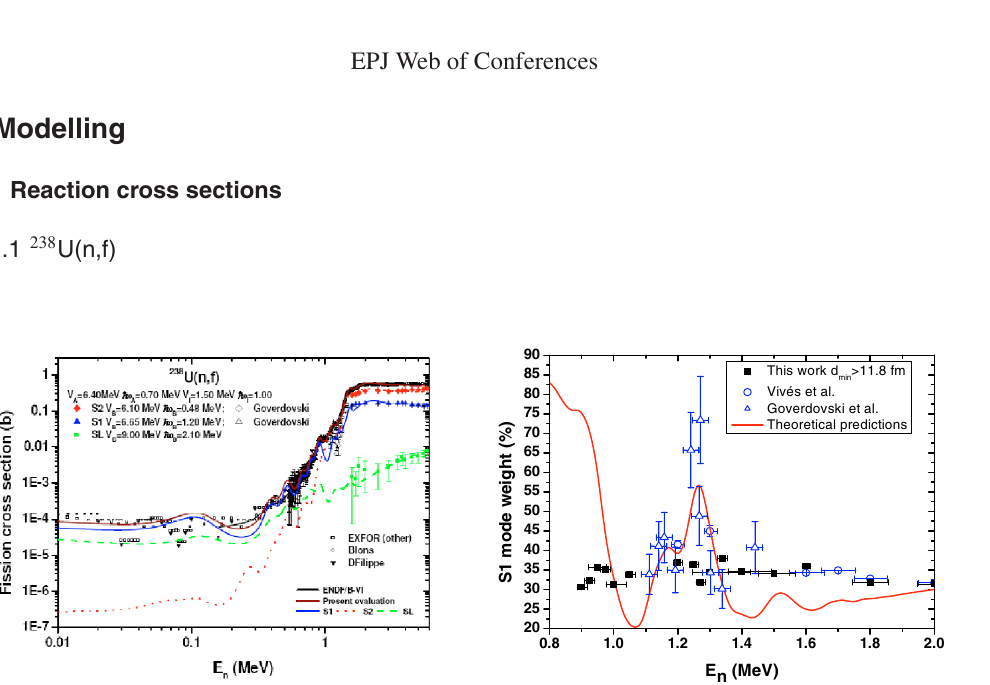
Fig. 1. Left part: The total fission cross section in comparison with mode separated fission cross sections for 238 U(n , f) together with the corresponding calculated mode separated fission cross sections (broken lines). Right part: The predicted modal branching ratio for the Standard 1 mode (full line) as a function of incident neutron energy [1] compared to the most recent experimental data (full points) of Ref.